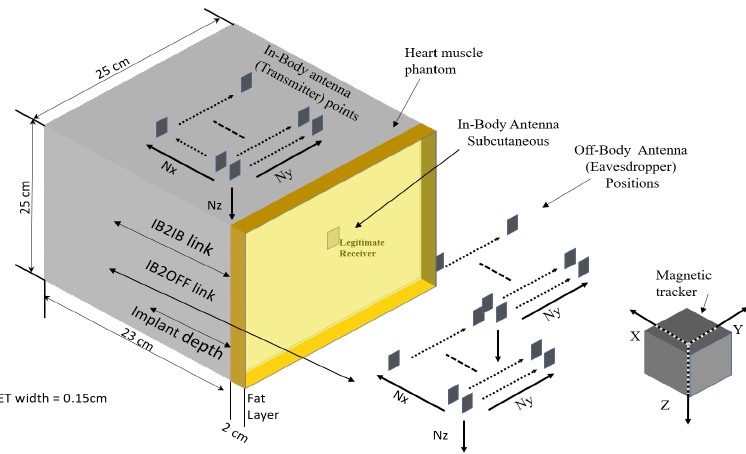
Figure 10. Measurement Grid